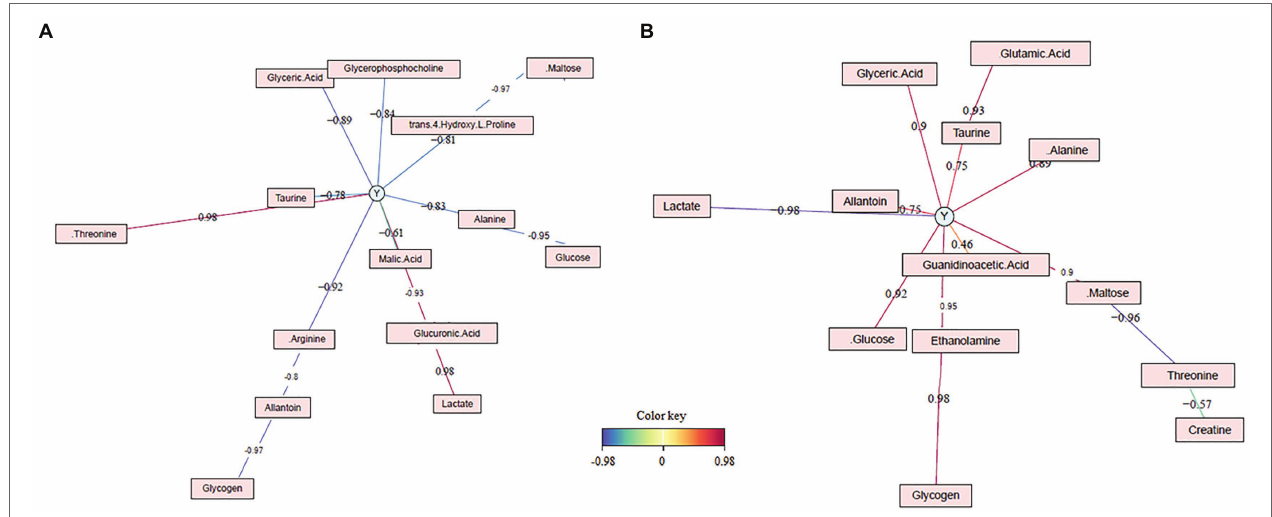
FIGURE 7 | Correlation networks of foie gras biomarkers (A) of liver weight (Y represents the liver weight) and (B) of liver technological yield (Y represents the technological yield). The relative concentration used for the correlations are calculated with the bucket